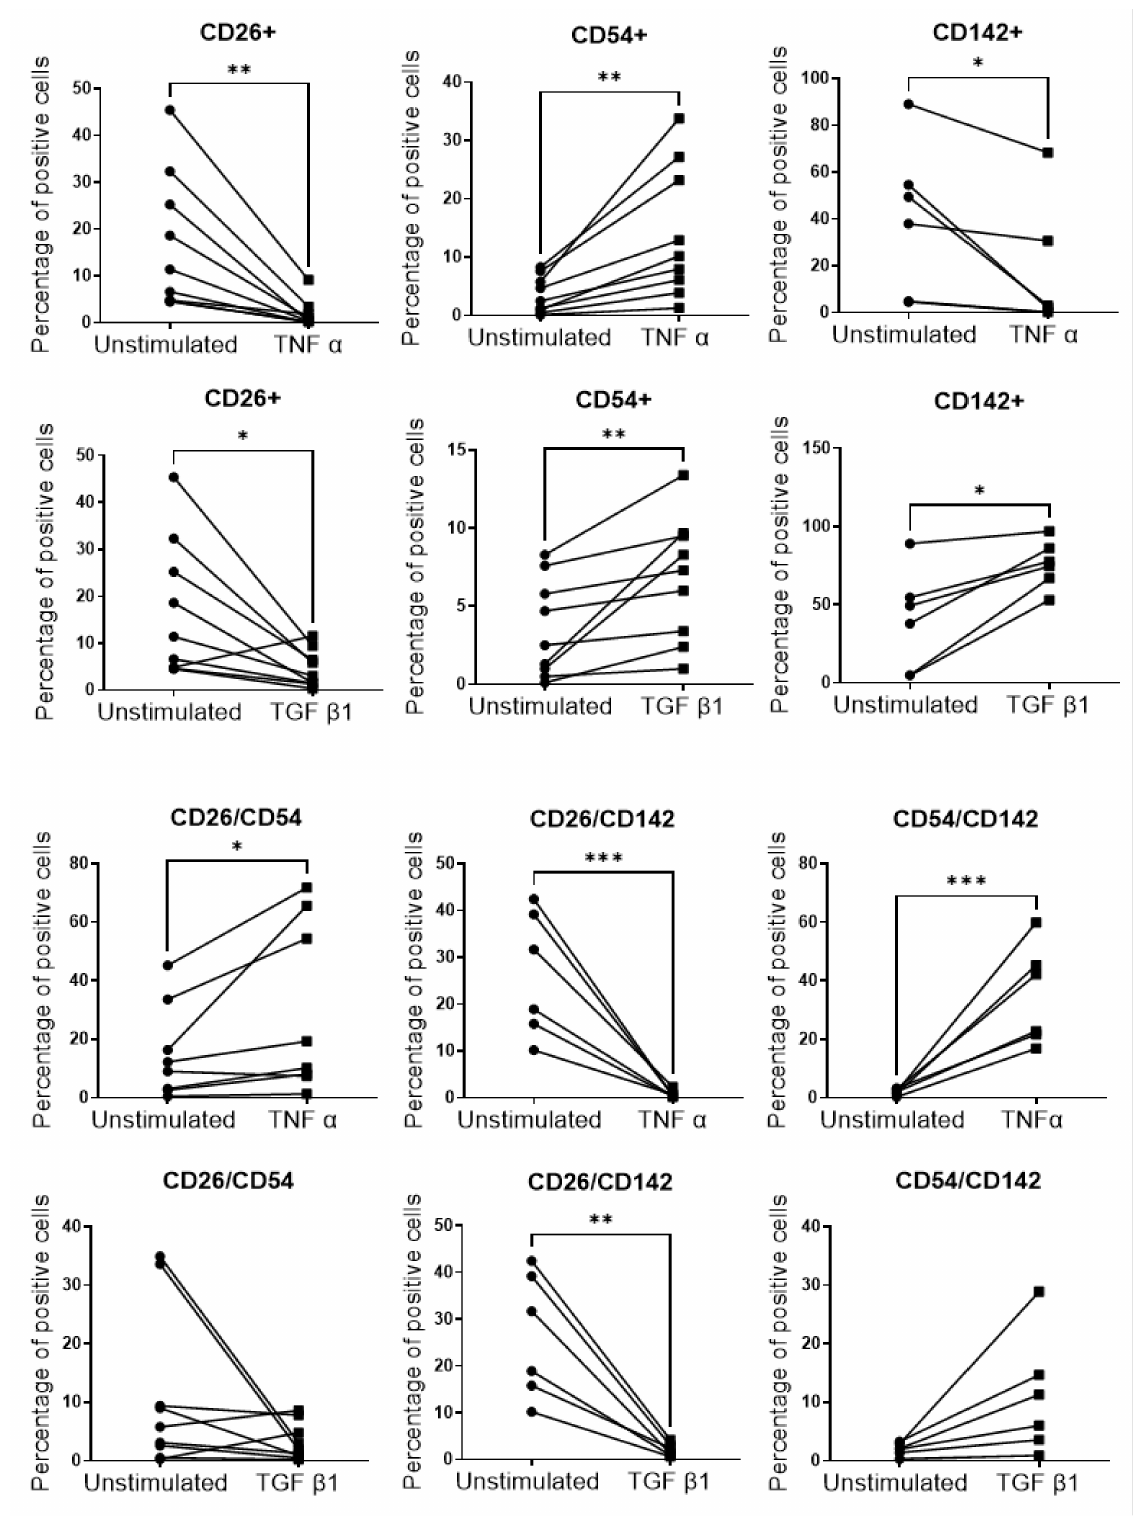
Figure 6. Percentages of APC subtypes in untreated and TNF α or TGF β 1-treated Ex-AdEx models; n = 5–9 donors. * p ≤ 0.05; ** p ≤ 0.01; *** p ≤